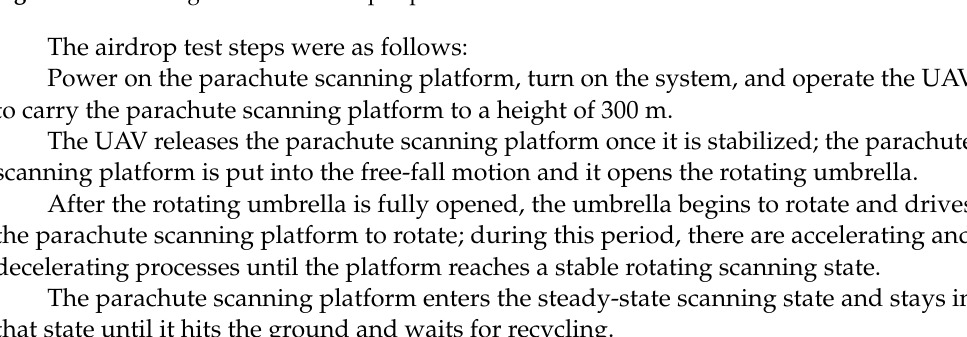
Figure 11. Flow diagram of the airdrop experiment.